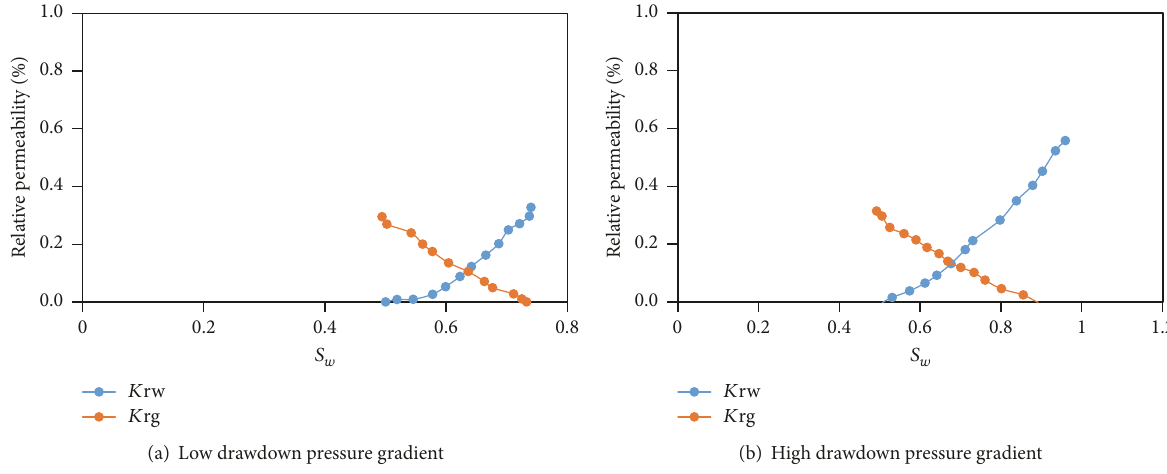
Figure 4: Gas-water relative permeability under different drawdown pressure